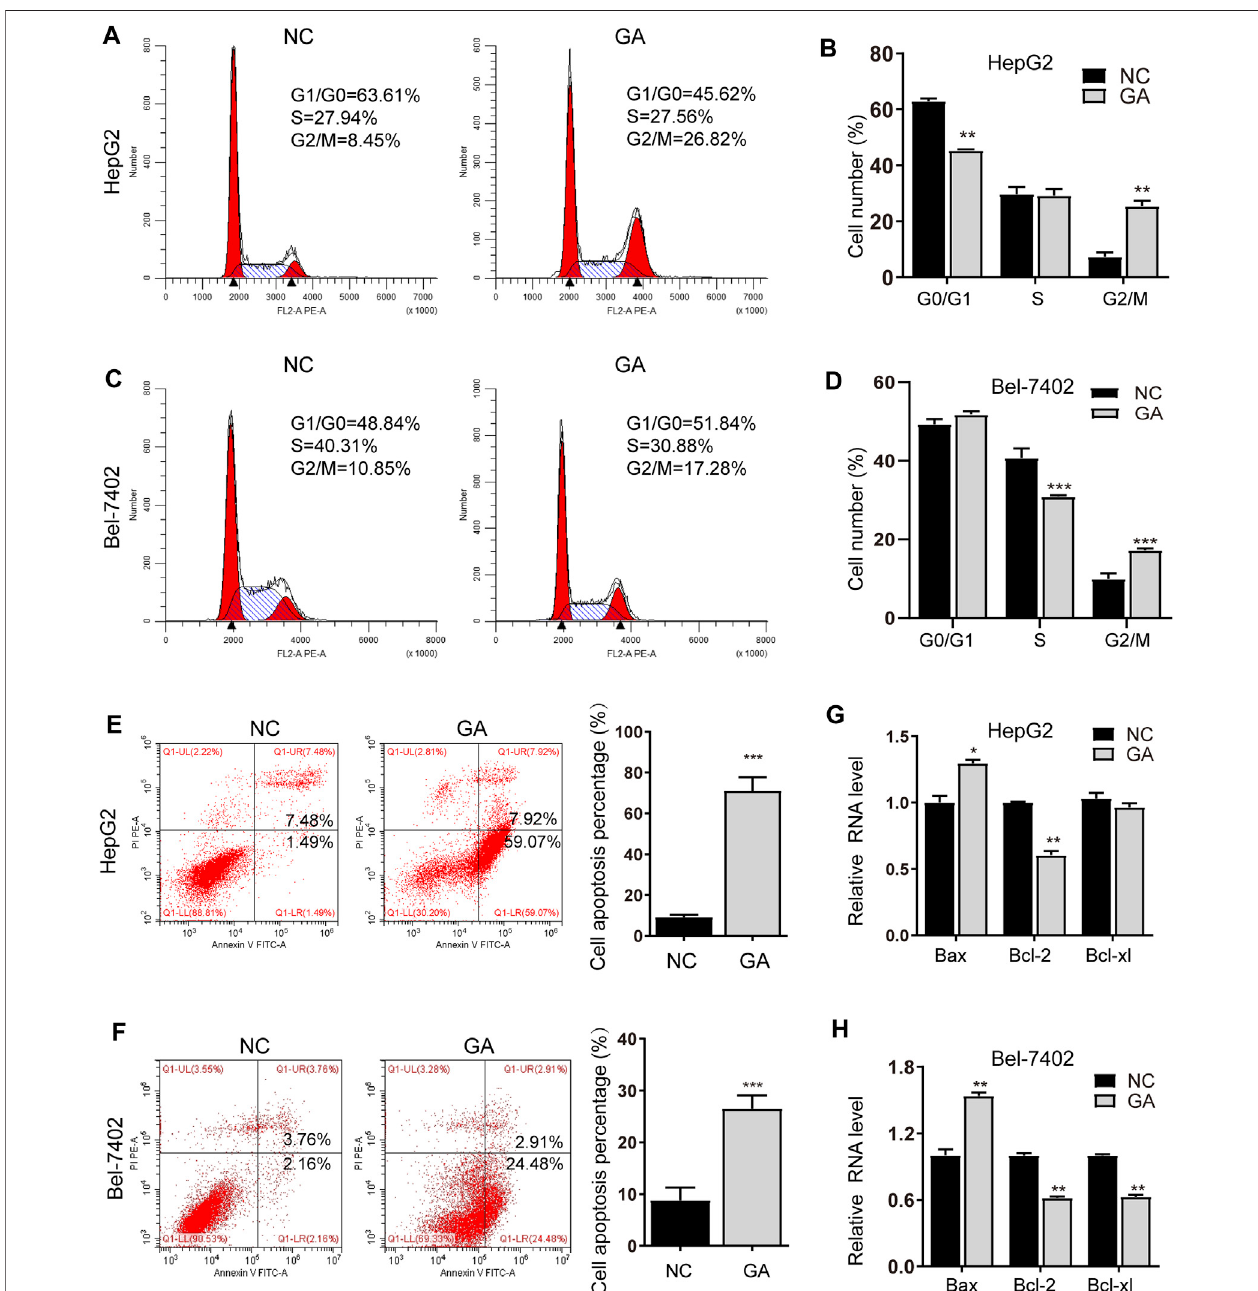
FIGURE 2 | GA induced cell cycle arrest and apoptosis in HCC cells. HepG2 and Bel-7402 cells were treated with 120 μ M GA for 48 h, and cell cycles were determined by fl ow cytometry assay. GA induced the signi fi cant arrest at G2/M phase in HepG2 cell (A,B) and Bel-7402 cell (C,D) . GA induced apoptosis in HCC cells. (E,F) HepG2 (E) andBel-7402 (F) cellsweretestedwith120 μ M GAfor48h,andtheapoptoticcellswereexaminedbyannexinV-FITCandPIdoublestaining. (G,H) The mRNA expression ofBax,Bcl-2 and Bcl-xlwere examined inGA-treated HCC cells. GAPDHwereused asanendogenouscontrol.*, p < 0.05; **, p < 0.01;***, p < 0.001; vs